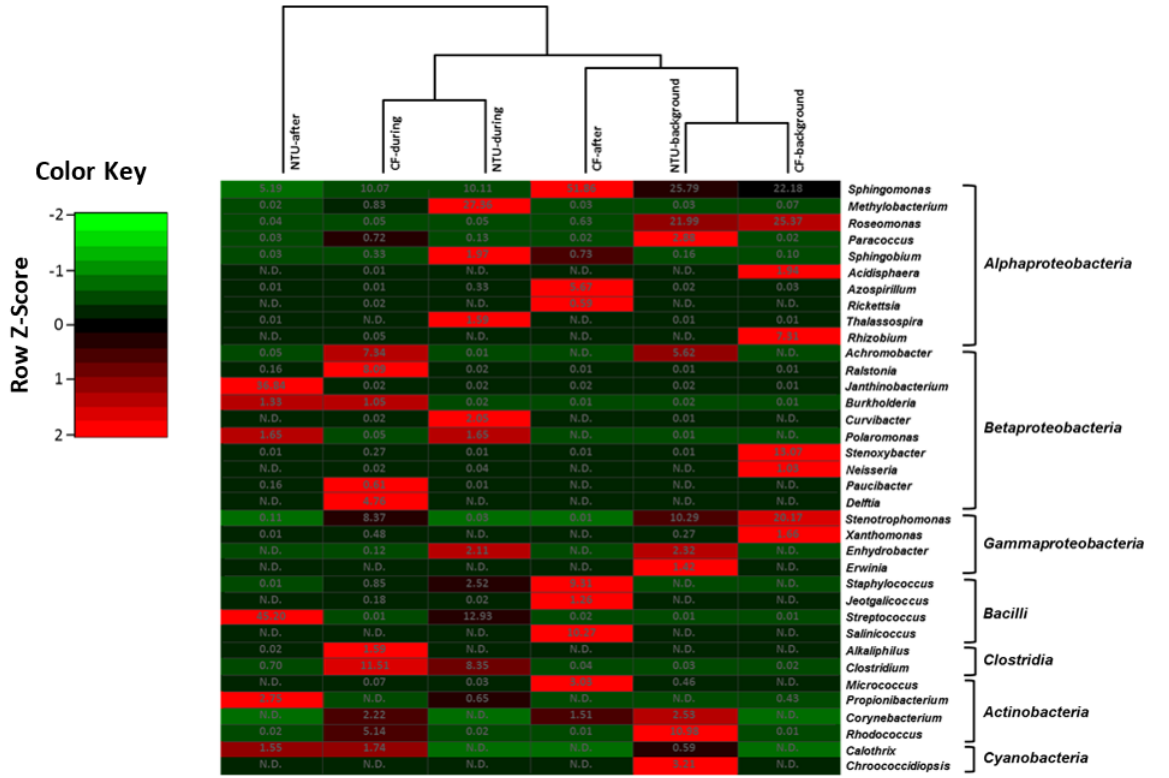
Figure 7. Heat map displaying the similarity among bacterial community structures in samples collected on background days as well as during and after the Asian dust storm based on the sequence frequencies of the top 10 genera. The numbers in the heat map refer to the relative abundance (%) of all genera in a specific sample. The color key shows the standard deviations of sequence frequency from the mean, with light green depicting low frequency and light red depicting high frequency. The genera with the relative abundance of less than 1% were not listed.